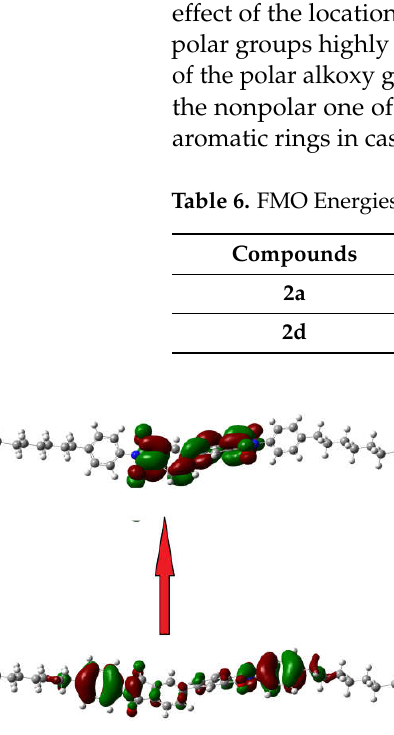
Figure 8. The estimated plots for frontier molecular orbitals of the prepared compounds 2a and 2d .